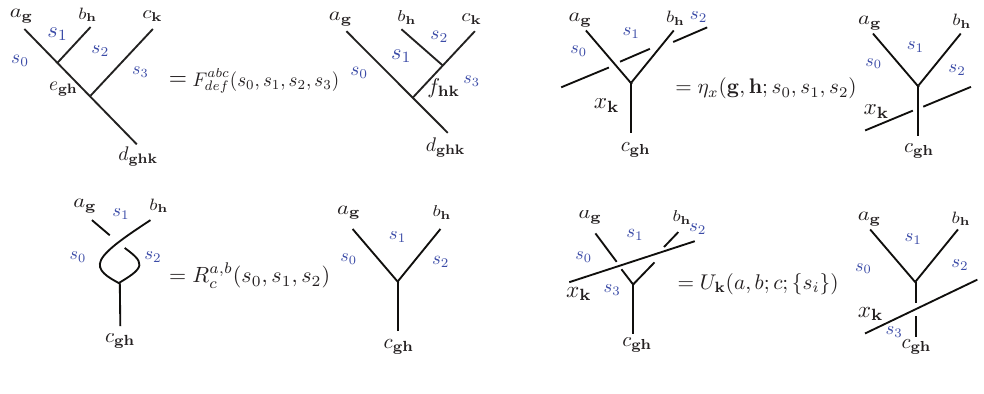
g in the regions between i